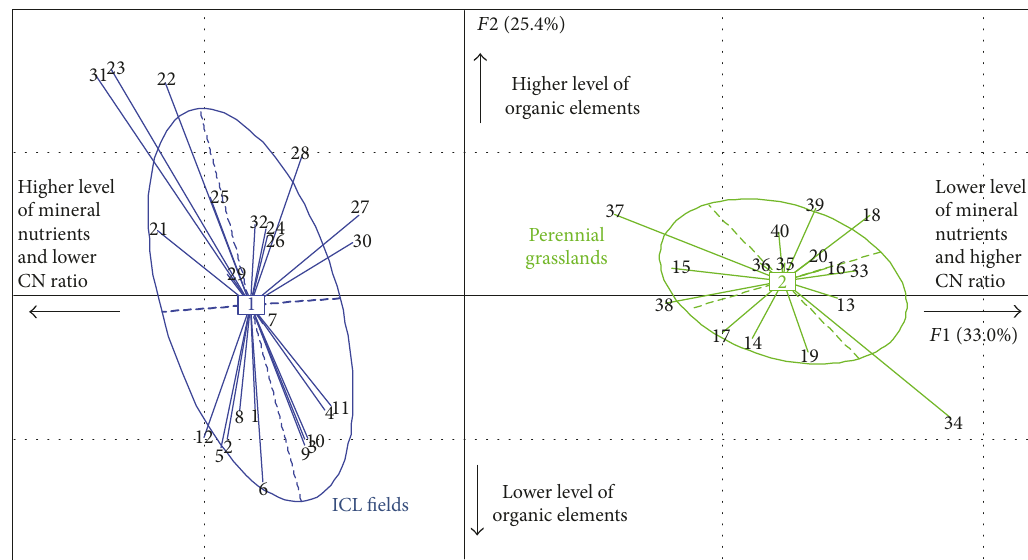
Figure 3: Spatial representation of two groups of soil trajectory types following principal component analysis of the complete dataset.